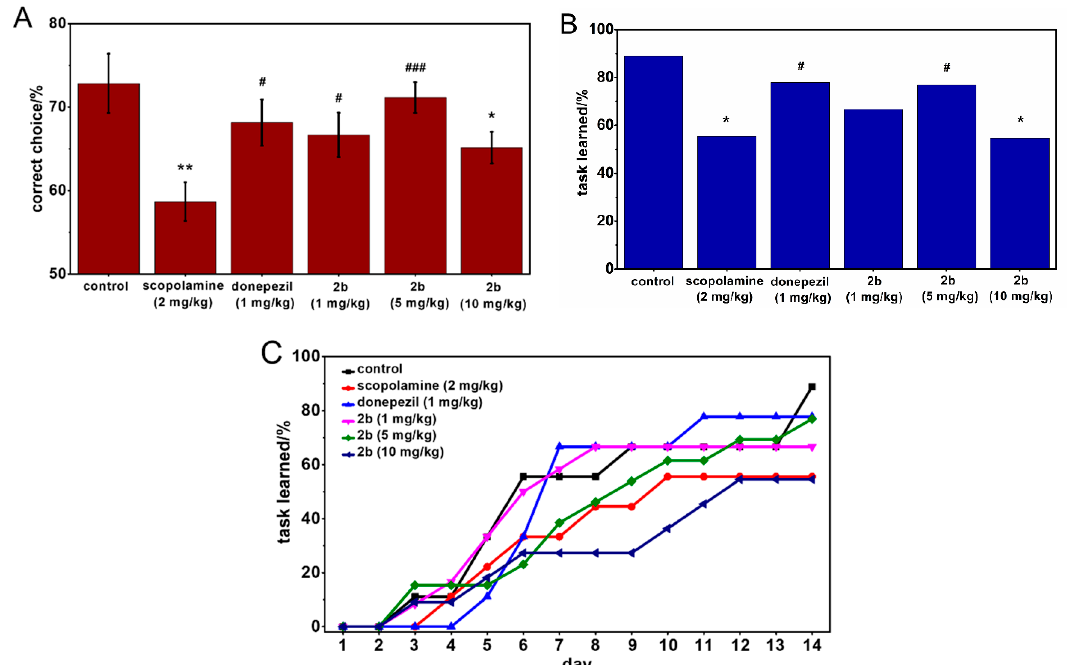
Figure 5. Effect of compound 2b with 6-methyluracil moiety, pentamethylene chains, and tertiary amino groups on spatial memory performance in an Alzheimer disease (AD) scopolamine mouse model. Graphs represent percentage of correct choices in the T-maze test. Data are expressed as mean ± standard error. Statistical analysis was performed using the Mann–Whitney test ( A ), percentage of mice reaching the criterion of learning the task by day 14 in the T-maze test. Statistical analysis was performed using Fisher’s exact test ( B ) and dynamic of reaching the criterion of learning the task ( C ); * p < 0.05, ** p < 0.01 compared to control group; # p < 0.05, ### p < 0.001 compared to scopolamine-treated group.